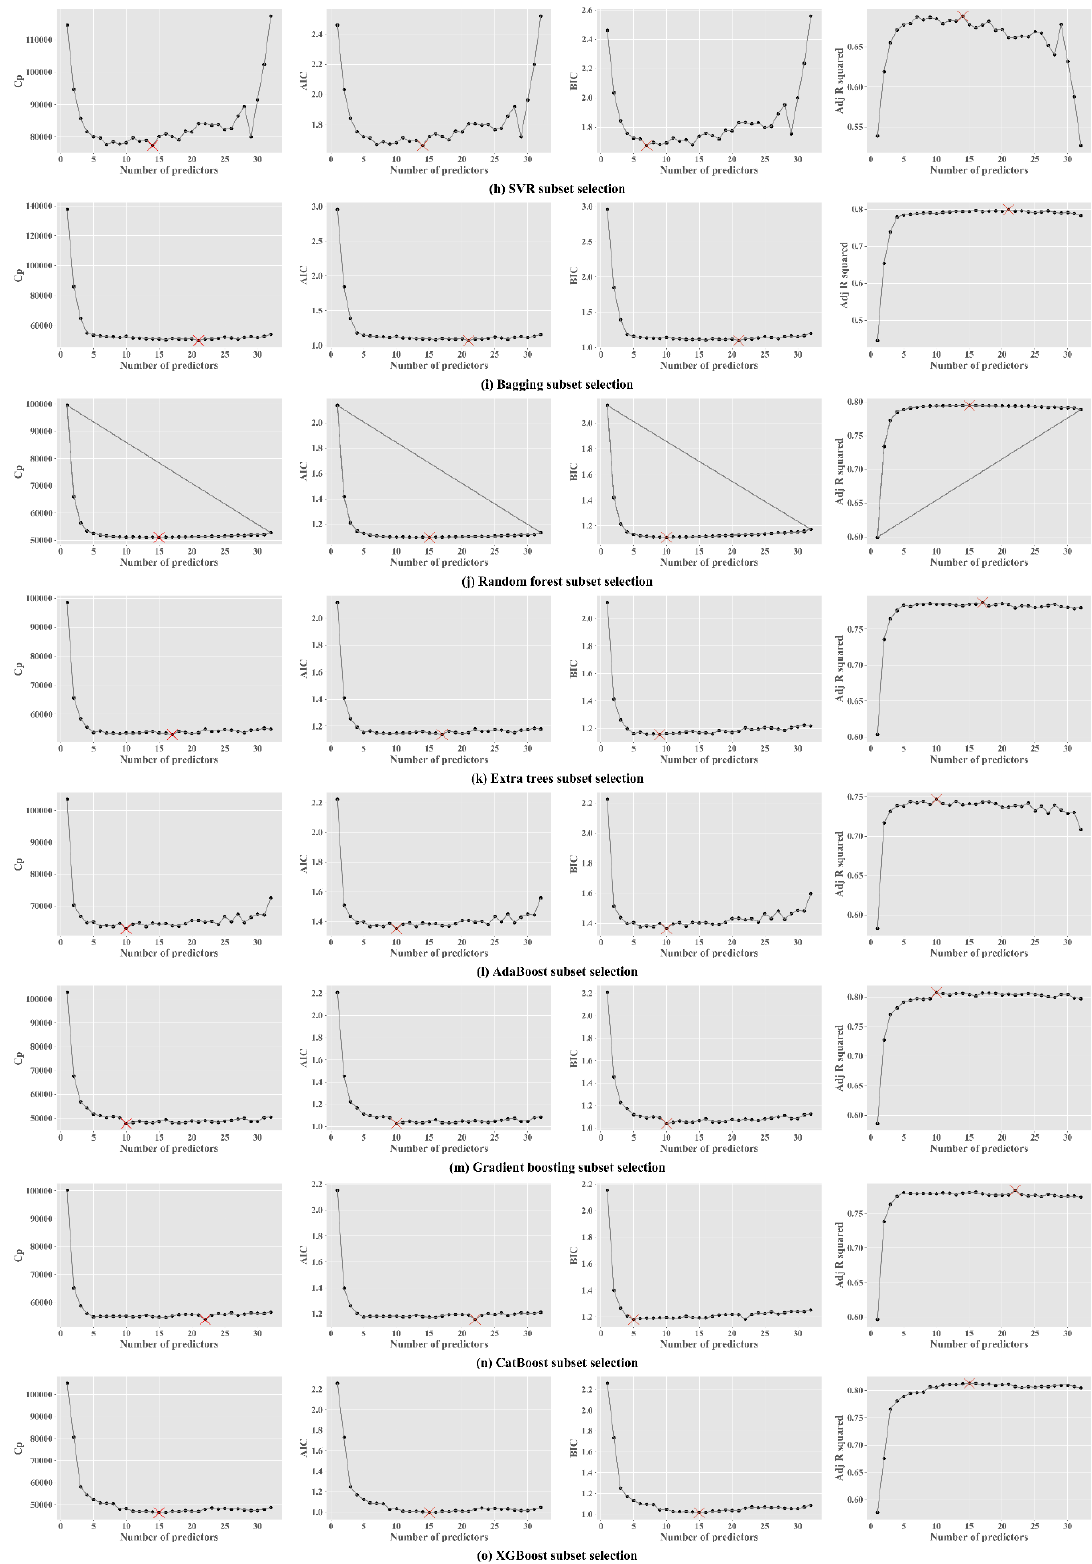
2 p , AIC, BIC and adjusted R